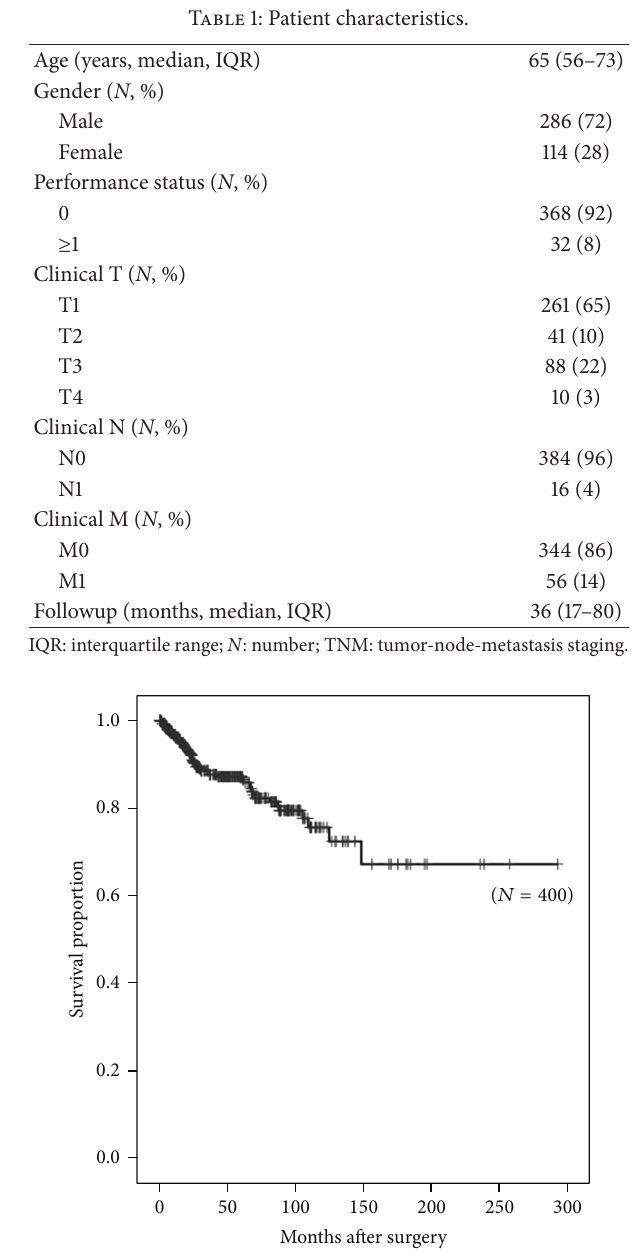
Figure 1: Kaplan-Meier estimate of overall survival. The 3-year overall survival rate was